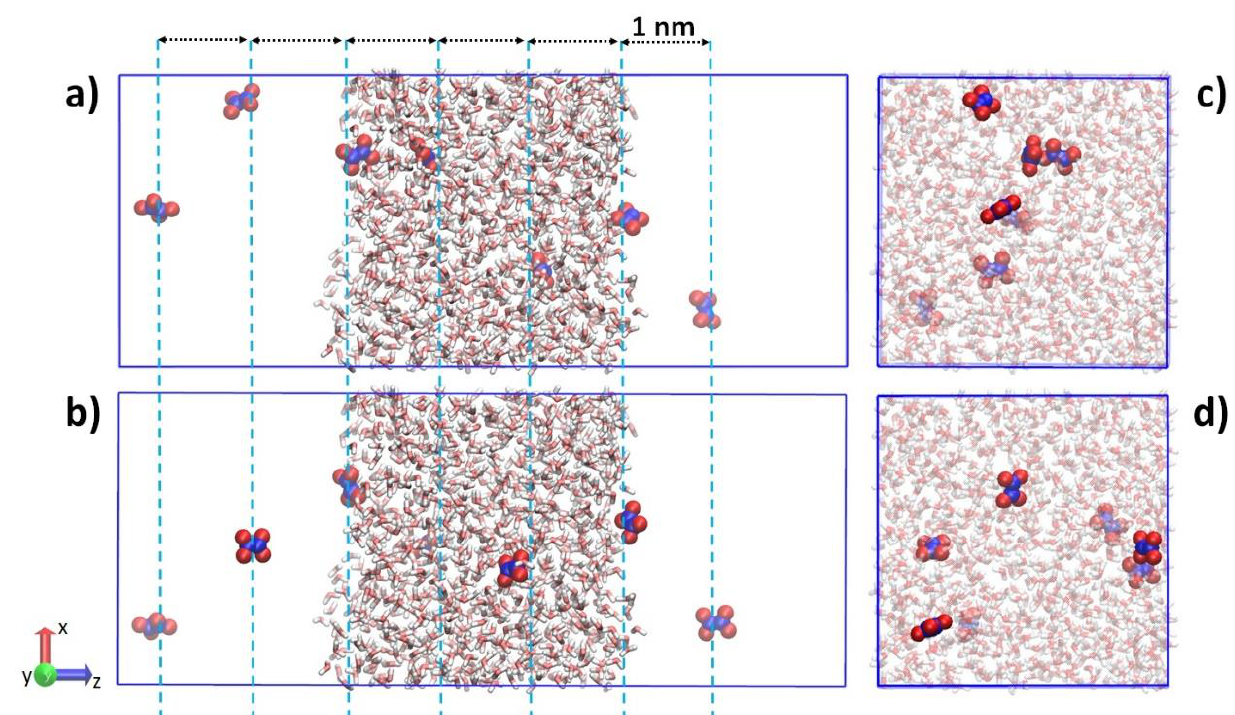
Figure 1. ( a ) The positions of seven N 2 O 4 inserted into the model system and separated by a 1 nm distance along the z-axis. ( b ) The same positions were used to insert seven N 2 O 4 along the z-axis, but randomized on the x-y plane. ( c , d ) Top views of the model system. N 2 O 4 is represented in VDW view and water molecules are illustrated in licorice view.